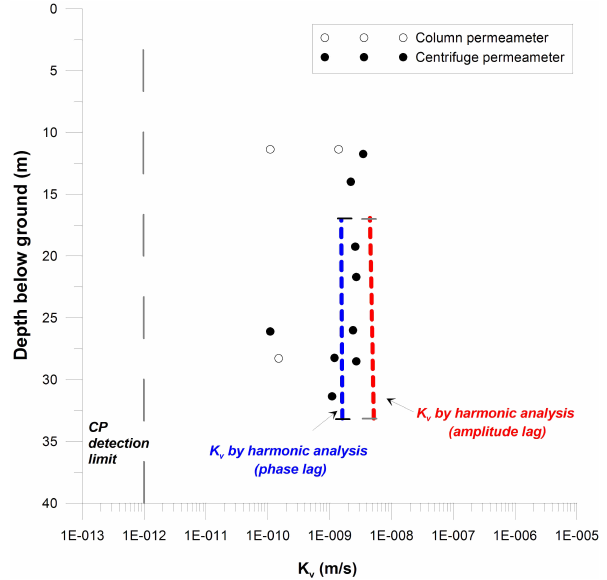
Figure 4. Vertical hydraulic conductivity ( K v ) measurements by centrifuge permeameter and column permeameter compared with in situ K v derived from pore pressure data at 6h intervals over 4 years interpreted with harmonic analysis (after Timms and Ac- worth, 2005) for the Cattle Lane site with massive clayey-silt from the surface to 35m